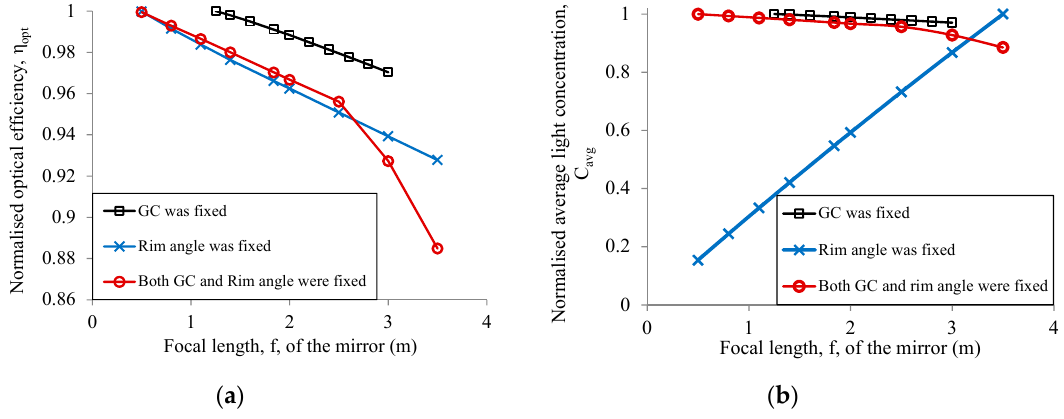
Figure 10. Effect of mirror focal length on ( a ) normalised η opt and ( b ) normalised C avg for different rim angle and GC.